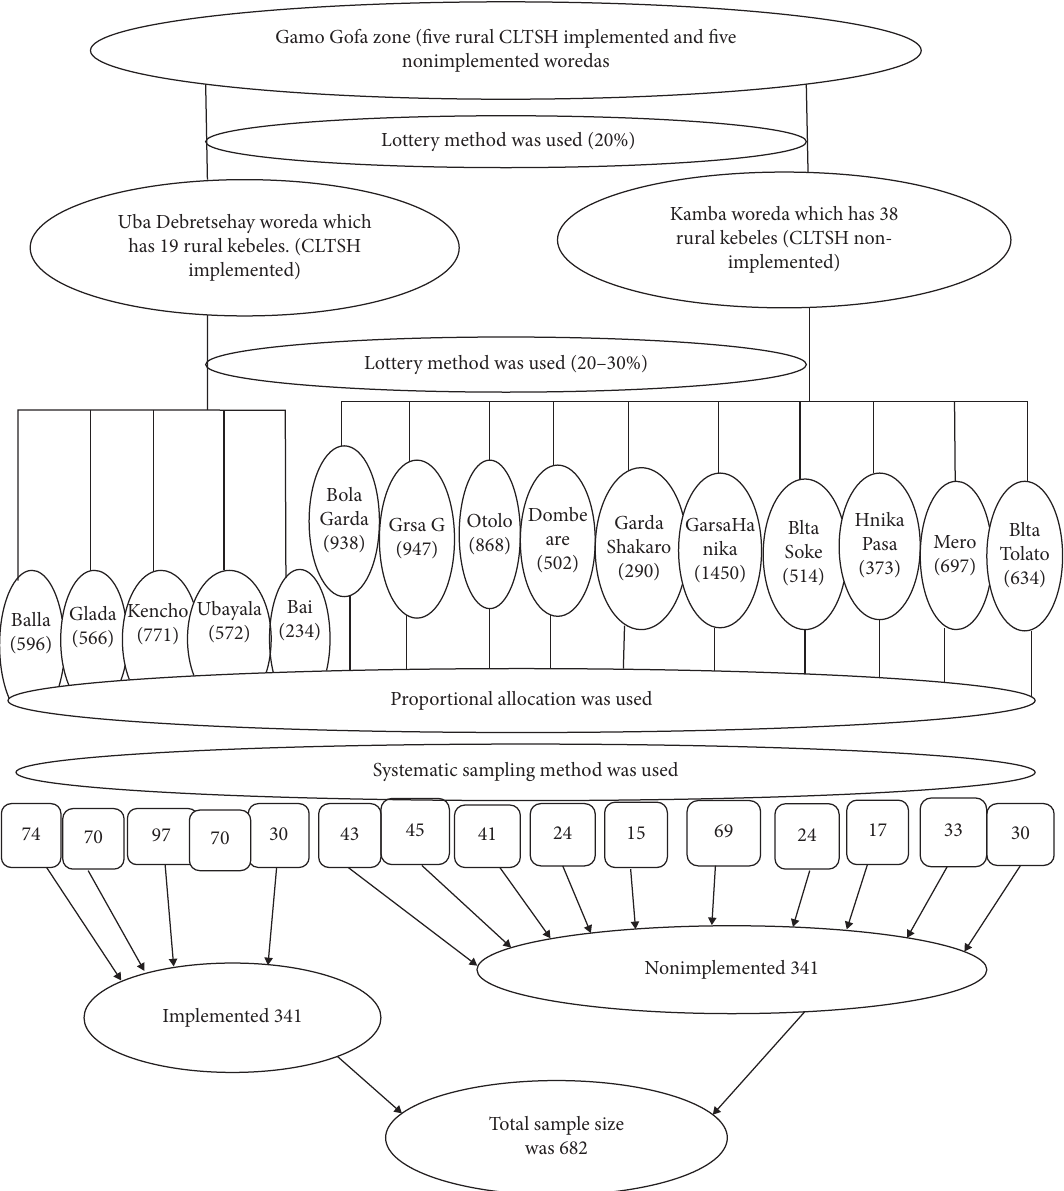
Figure 1: Schematic representation of sampling procedure on prevalence and factors associated with diarrhea among under-five in CLTSH implemented and nonimplemented areas in Gamo Gofa Zone,